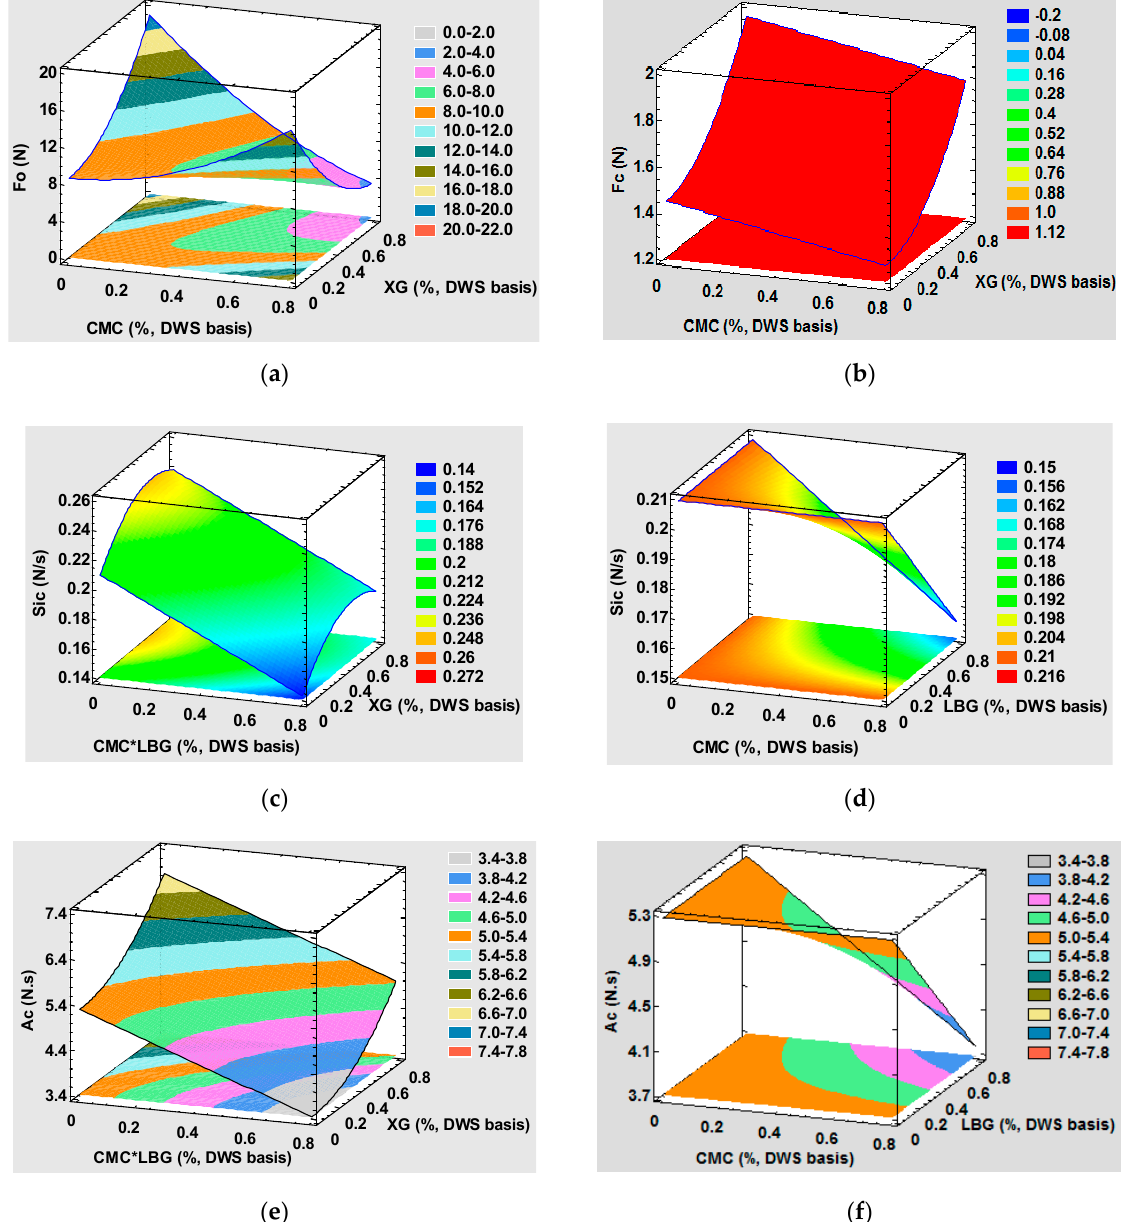
Figure 1. ( a – f ). Effect of the CMC, GX, and LBG levels on the uncooked and cooked firmness (F o and F c , respectively) and on cooked elasticity (S ic ) and consistency (A c ). CMC, carboximethylcelullose; XG, xanthan gum; LBG, locust bean gum.